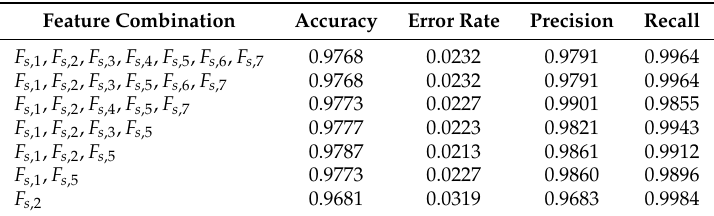
Table 5. Feature selection from F s .